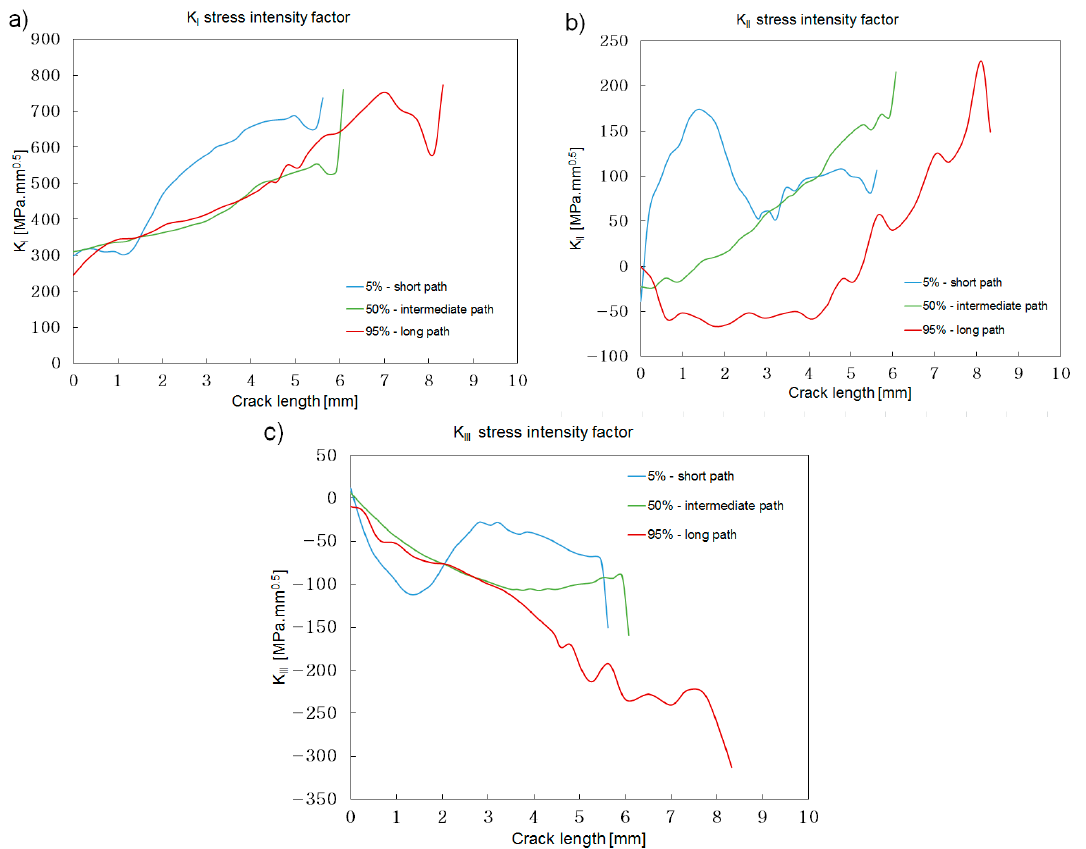
Figure 12. The 30° angle, short flank stress intensity along the three crack paths selected: ( a ) K I ; ( b ) K II ; ( c ) K III .